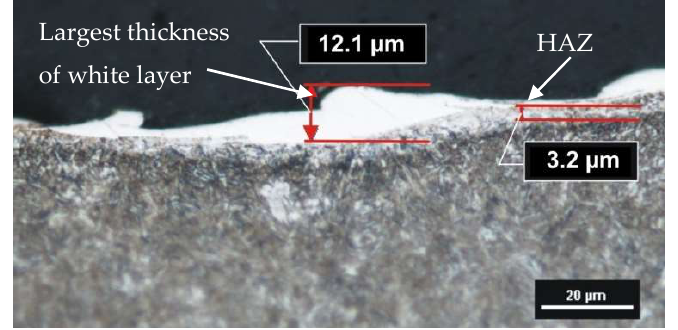
Figure 7. The metallographic structure of tool steel 55NiCrMoV7 after EMD: U c = 25 V, I = 14 A, t on = 13 μs, t off = 10 μs.